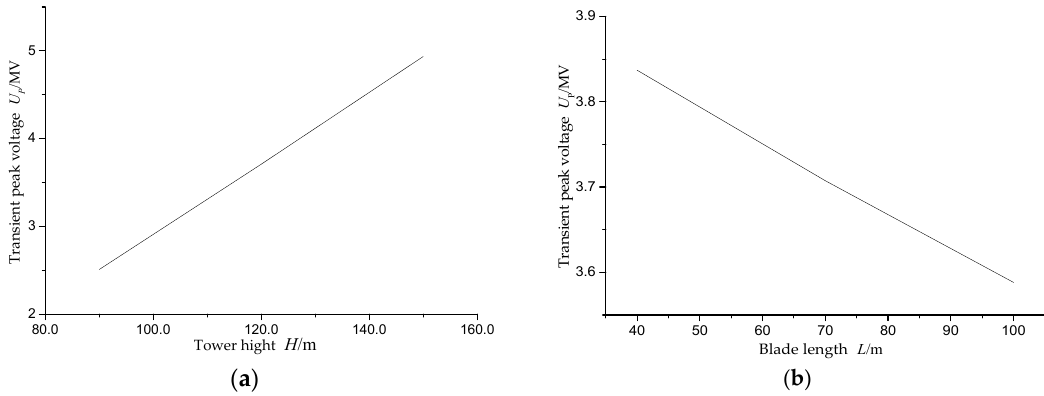
Figure 11. Effect of blade length and tower height on transient potential peak, ( a ) Effect of tower height on transient potential peak, ( b ) Effect of blade length on transient potential peak. Table 2. Effect of blade length and tower height on transient potential oscillation frequency. Leaf Blade Length L /m Tower Height H /m